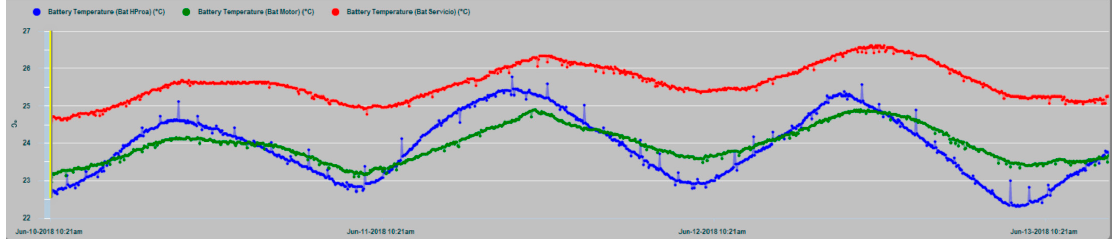
Figure 17. Time series of the T in internal temperatures of the house battery bank (red), bow thruster battery bank (blue), and engine battery bank (green).